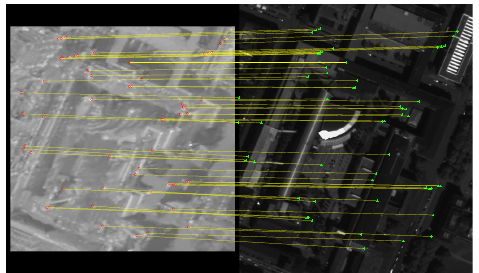
Table 2. The statistic result of the 3D reconstruction accuracy.